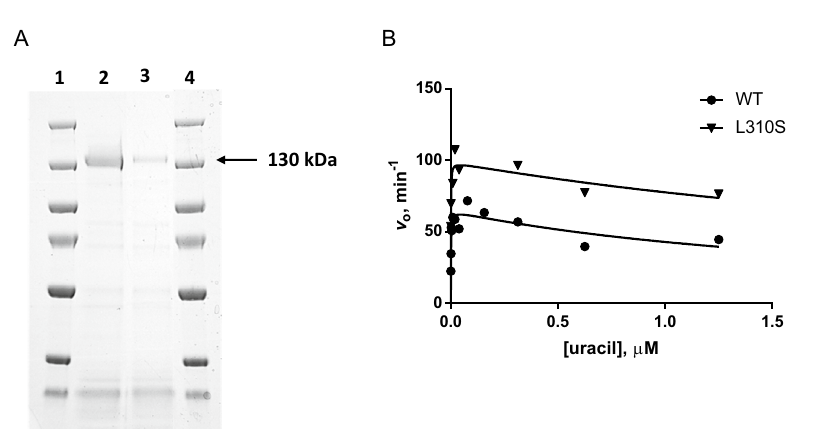
Table 1. Validation of RNAseq differentially expressed genes through quantitative PCR. Fold change expression levels were calculated via delta delta Ct method relative to a.) 0 nM Gimeracil either in the presence or absence of FFA or b.) 200 µM FFA treatment relative to 0 µM FFA in the absence of Gimeracil. Significant differences in fold change expression level are denoted in bold with * indicating adjusted p value < 0.05 and ** indicating p < 0.0001. The role of each gene in hepatic metabolism is summarized in the right column of the table.